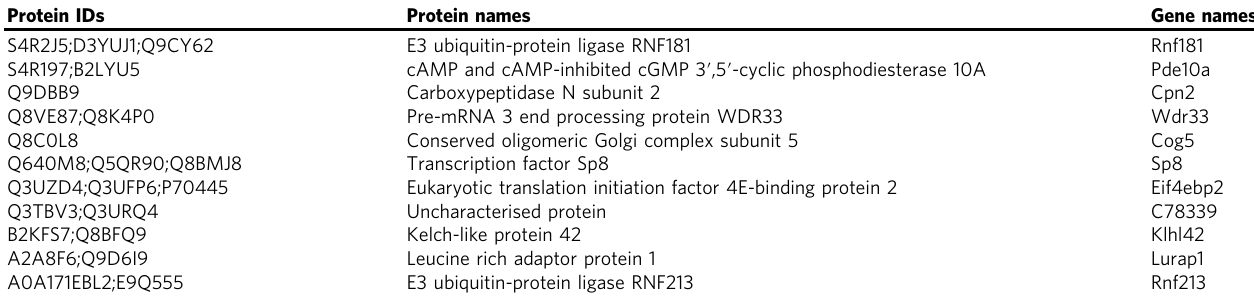
Table 2 Distinct proteins in